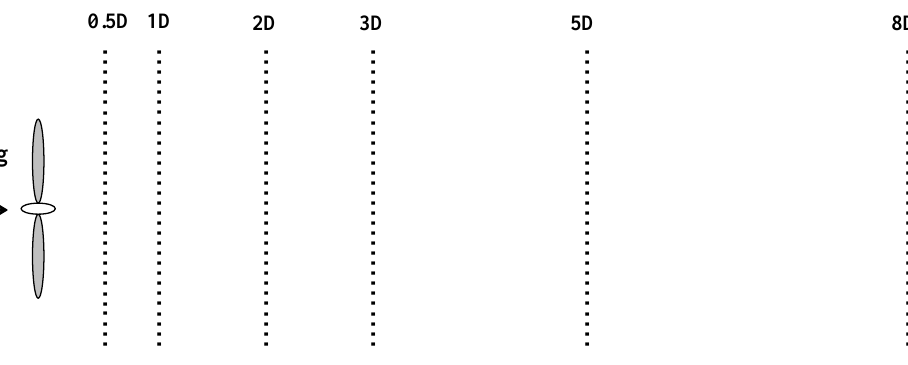
Figure 10. Distribution of flow field measuring points (horizontal plane at hub height).